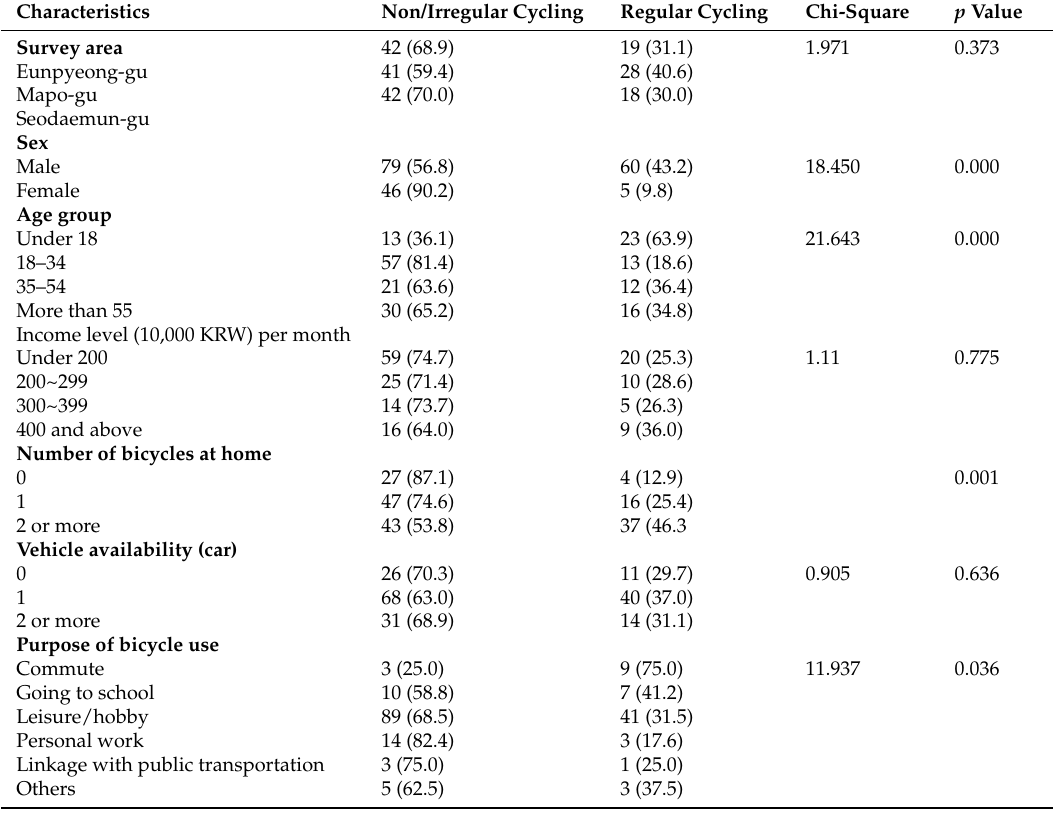
Table 4. Association between the type of cyclist and socio-demographic factors.